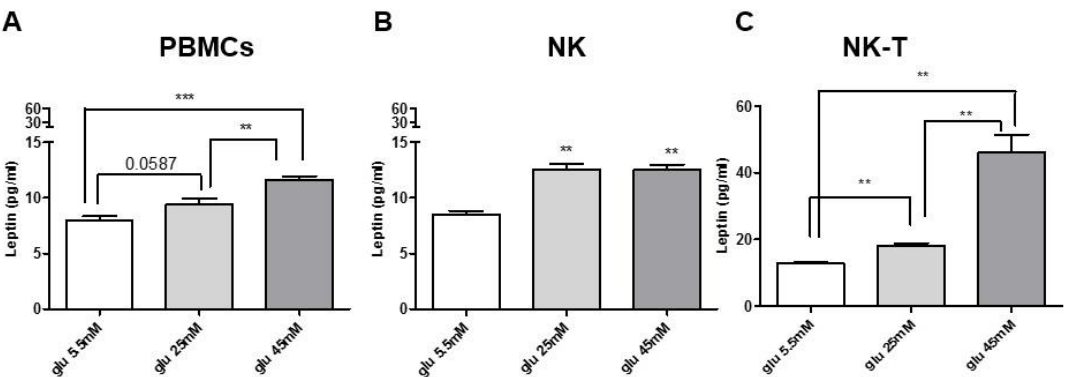
Figure 6. PBMCs, NK cells, and NK-T cells isolated from healthy donors were treated with high glucose concentration for 48 h. Glucose were added every 24 h at 5.5 mM, 25 mM, and 45 mM concentrations. Total PBMCs ( A ) had a significant increase in leptin secretion after 45 mM glucose vs. both 5.5 mM glucose and 25 mM glucose; on the contrary, PBMCs treated with 25 mM glucose did not have a significant increase in leptin secretion ( p = 0.0587). Isolated NK cells ( B ) dis- played a significant increase in leptin secretion in response to 25 mM glucose and 45 mM glucose stimulation compared to 5.5 mM. NK-T cells ( C ) showed a significant increase in leptin secretion in the same experimental conditions as NK cells, with the highest levels in response to glucose 45 mM (~46 pg/mL). Data are expressed as mean ± SEM for three healthy donors and were analyzed with a Wilcoxon – Mann – Whitney U Test (** p < 0.005, *** p < 0.0005). PBMC: peripheral blood mononuclear cells; NK: Natural Killer; NK-T: Natural Killer-T; glu: glucose.